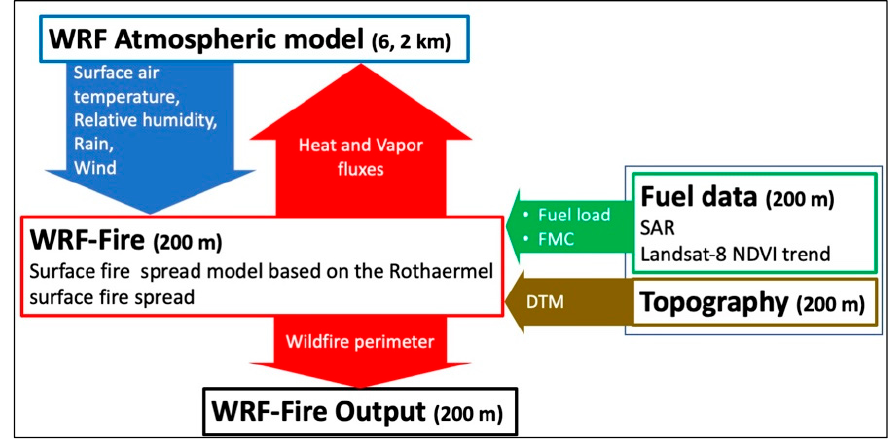
Figure 2. WRF-Fire model workflow: inputs, two-way interactions, and outputs.